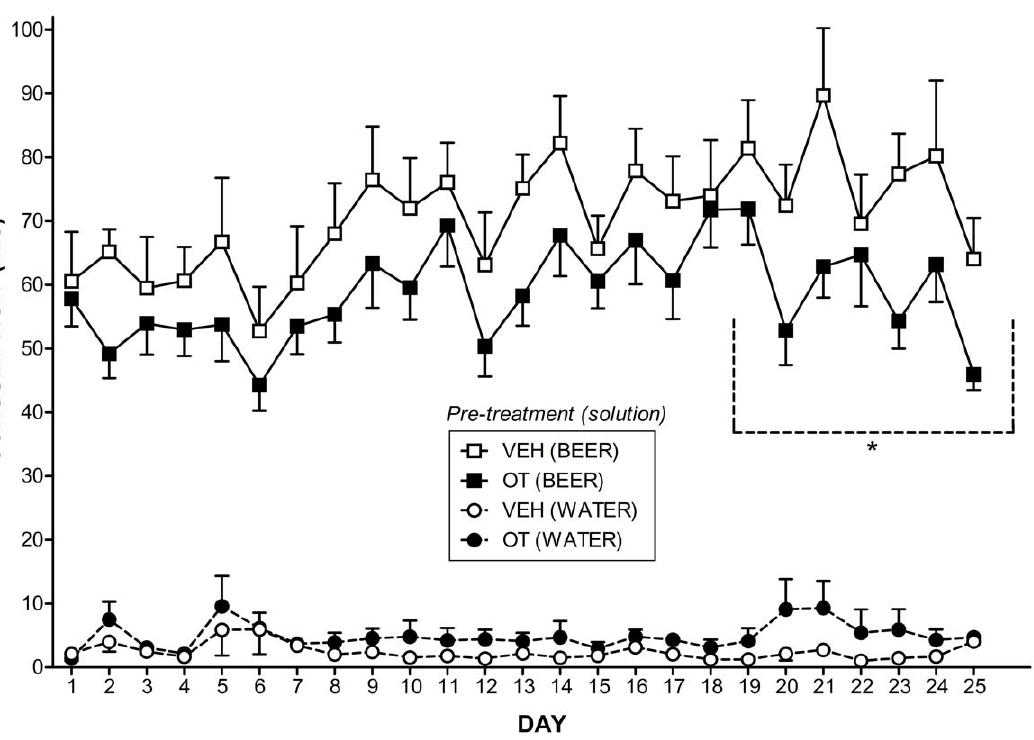
Figure 5. Alcohol and water consumption under continuous access. Mean ( 6 SEM) 4.44% EtOH beer and water consumption (in mls) for each of the 25 days of continuous access to beer and water is illustrated. Continuous access began 30 days after the cessation of 10 consecutive days of once per day treatments with either 1 mg/kg OT or equivalent VEH. Subjects were housed individually and had 24 h access to both beer and water over the entire 25 days. N=8 per condition. * indicates sig. difference in total beer consumption between OT and VEH over the final seven days of continuous access, p , 0.05.